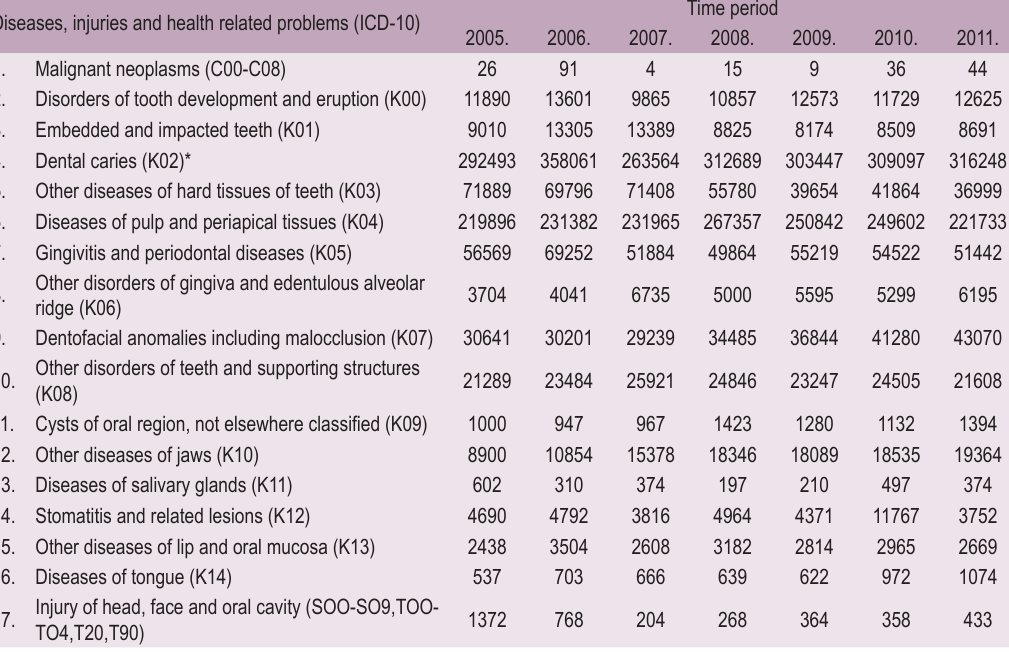
TABLE 2. Diseases, injuries and health related problems (ICD-10) registered by dental health care professionals in Federation of Bosnia and Herzegovina during time period from 2005.to